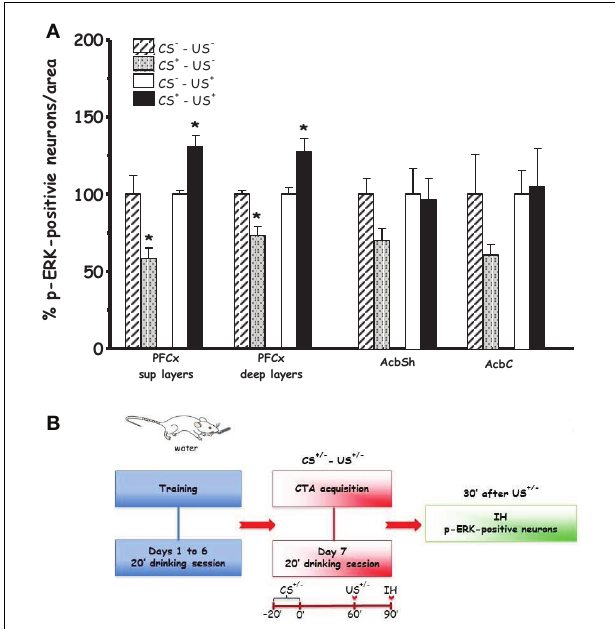
FIGURE 2 | Acquisition (Acq1) (A): Effect of CTA acquisition on % changes of p-ERK-positive neurons/area in the PFCx (superficial and deep layers) and Acb (shell and core). Data, average + s.e.m., are expressed as % changes with respect to the effect in control groups (CS − ) set as 100%. ∗ Indicates significant differences ( p < 0 . 05) of % changes of p-ERK-positive neurons with respect to control groups (CS − -US − and CS − -US + ) (One-Way ANOVA followed by LSD post-hoc test) ( n = 4 in each group); (B): timeline schedule of Acq1 experiment.